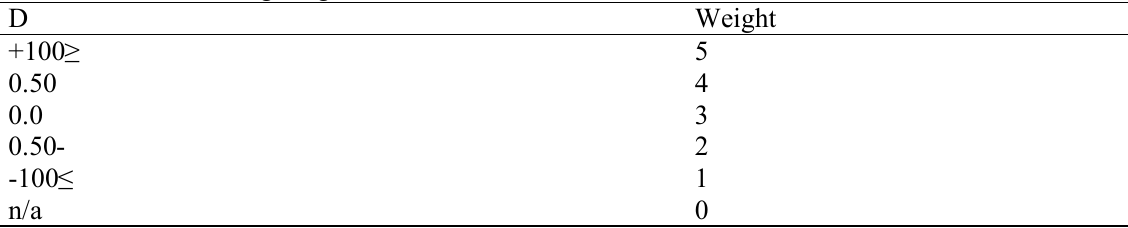
Table 7 . Reference Weighting